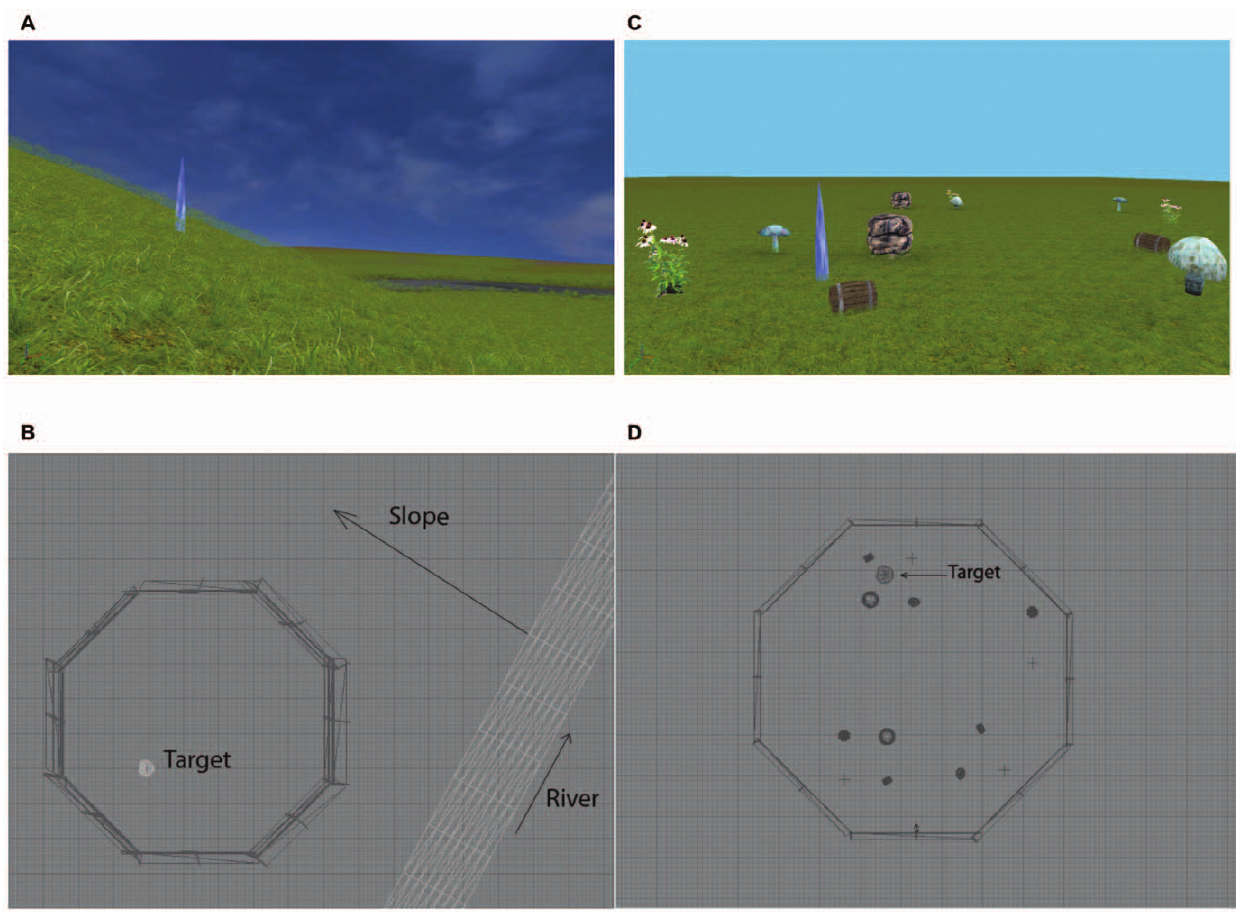
Figure 1. Representative virtual environments for the different cue class trials. Screenshot of a directional-cue trial (A), screenshot of a positional-cue trial (B), schematic of the directional-cue environment (C) (the arrow points up the slope), schematic of a positional-cue environment (D). The blue crystal (target) was located in one of the cue clusters.